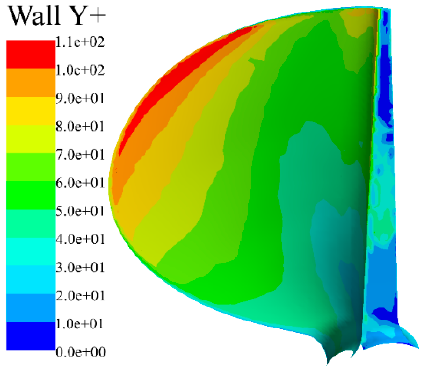
Figure 6. Contour of y + on SPP-1 key blade.